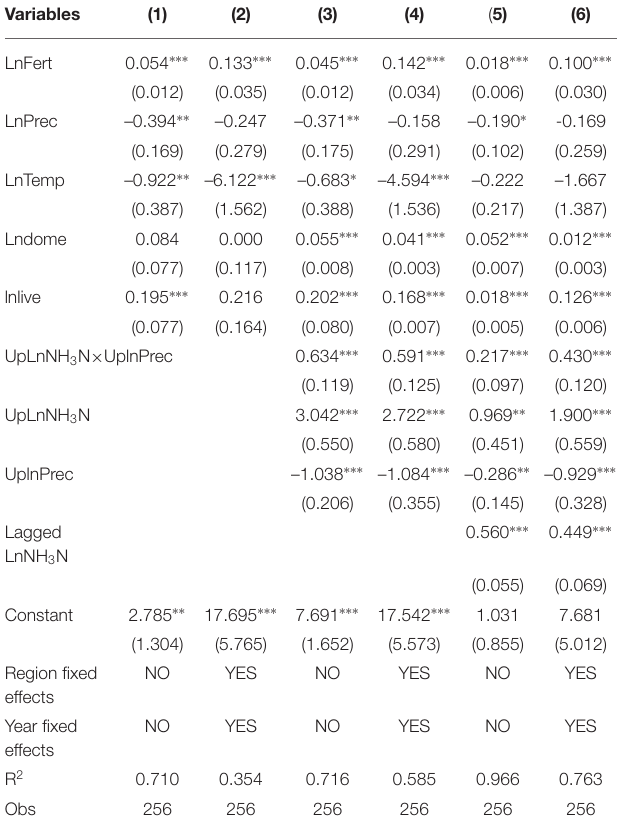
TABLE 3 | Robustness